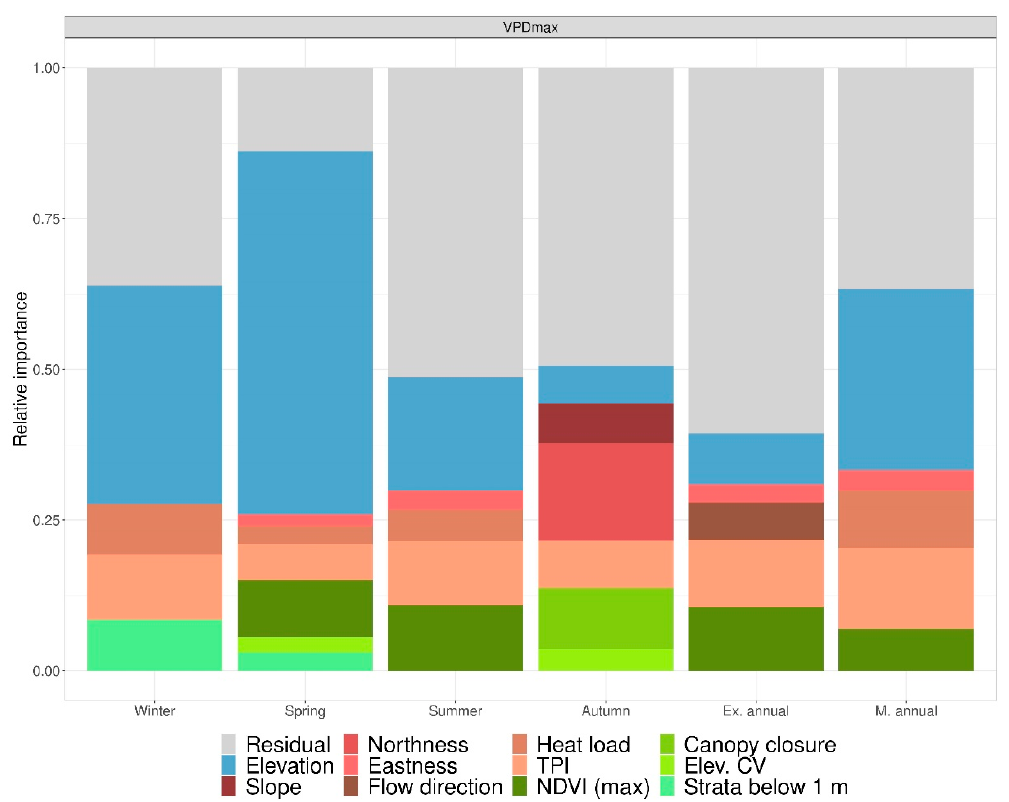
Figure 6. Relative importance of explanatory variables for modeling VPDmax from relative humidity and temperature recorded by in situ sensors in the air along 2100 m of elevation. The columns correspond to one of the six models: the four seasons, the annual extreme (Ex. annual), and the annual mean (M. annual).